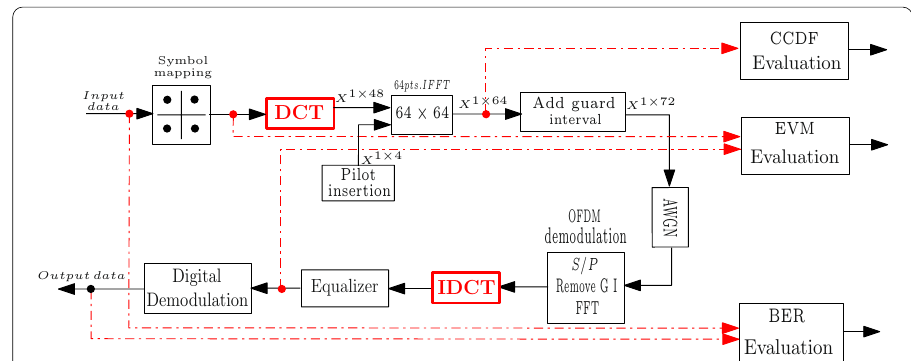
Fig. 2 Simulation block with the DCT (WLAN 802.11y standard)